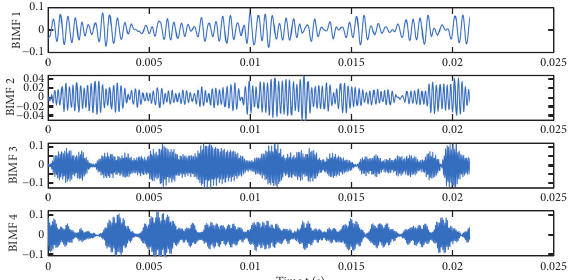
Figure 7: FFT spectrum of outer ring fault